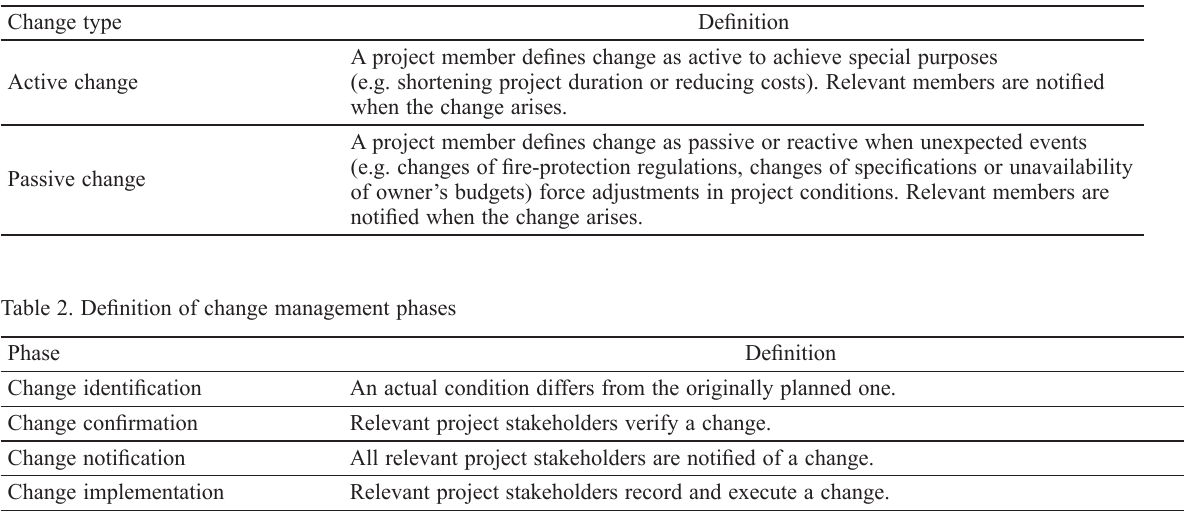
Table 1. Changes in change management